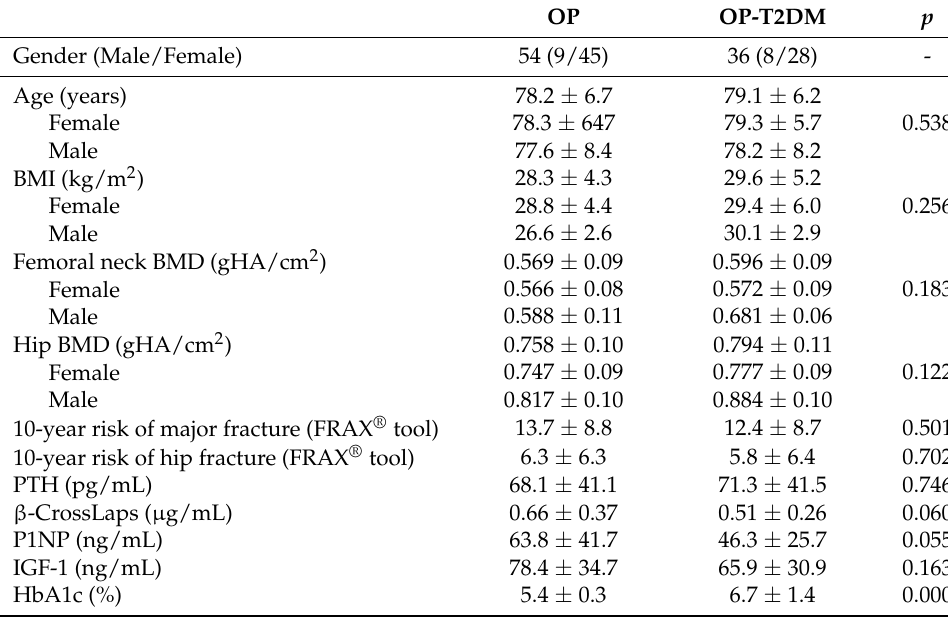
Table 2. Patient characteristics (total and by gender) and analyzed parameters. Values are shown as the means ± typical deviation